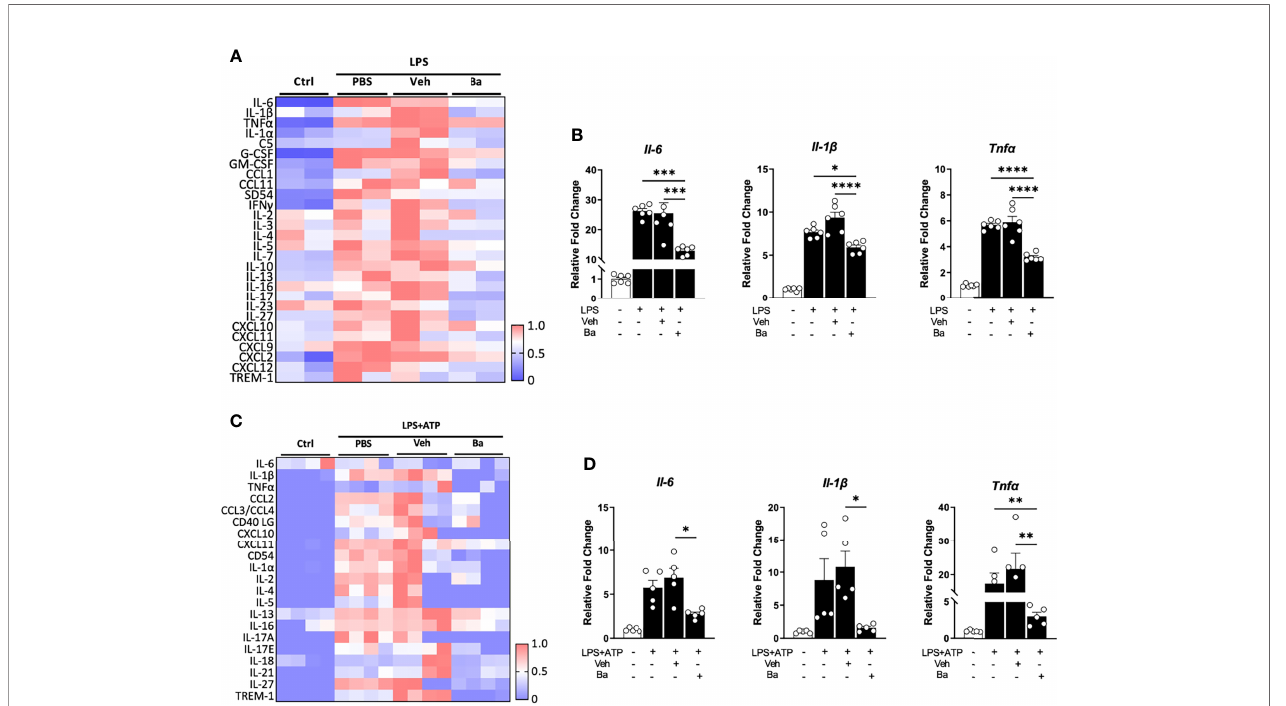
FIGURE 1 | Baicalein suppresses the activation of both human and mouse microglia. (A) Heatmap showing the quanti fi cation of cytokine expression in the supernatants of BV2 microglial cultures that received no treatment (Ctrl) or treatment with lipopolysaccharide (LPS) followed by PBS, vehicle control (Veh), or baicalein (Ba). The scale bar (0 – 1) of the heatmaps represents the raw pixel intensities normalized to the maximum intensity for each cytokine. (B) qPCR results showing the relative expression of pro-in fl ammatory cytokines in LPS-stimulated BV2 cells followed by Veh or Ba treatment. N = 6/group. Relative fold changes of genes were normalized to naive control group. (C) Heatmap showing the quanti fi cation results of cytokine protein expression from the supernatants of HMC3 cultures that received no treatment (Ctrl) or treatment with LPS+ATP plus PBS, vehicle (Veh), or baicalein (Ba). (D) qPCR results showing the relative expression of pro-in fl ammatory cytokines in LPS and ATP-stimulated HMC3 cells followed by vehicle (Veh) or baicalein (Ba) treatment. N = 5/group. Relative fold change of genes was normalized to naive control group. Data were presented as mean ± SEM. Each dot represented individual replicate. * P < 0.05, ** P < 0.01, *** P < 0.001, **** P < 0.0001, one-way ANOVA with Tukey ’ s multiple comparisons